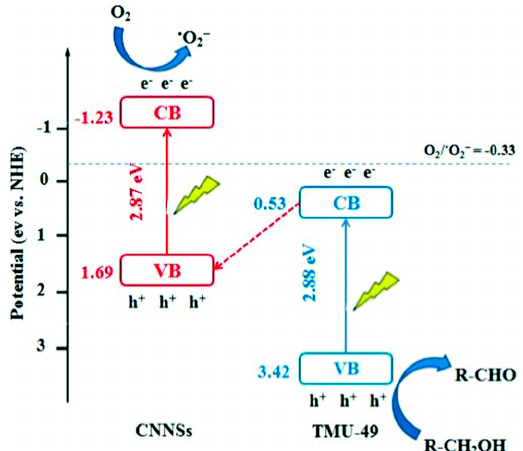
Figure 15. Schematic view of the alcohol oxidation mechanism (Reprinted with permission [167]. Copyright 2021 The Royal Society of Chemistry).